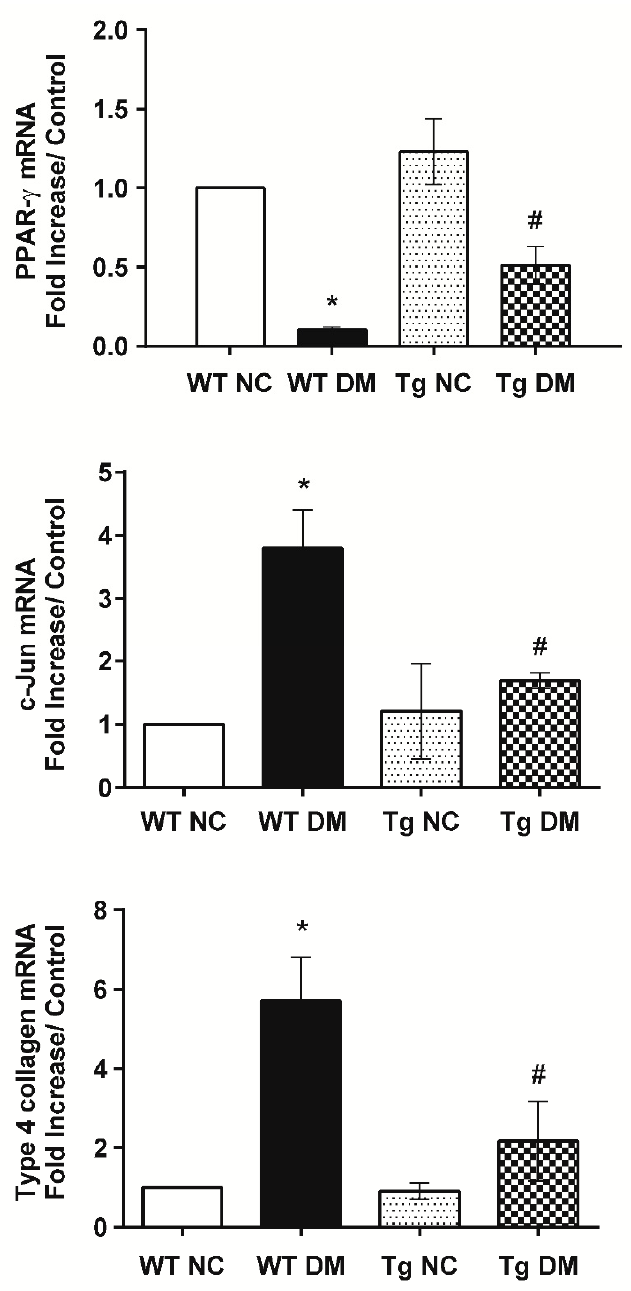
Figure 2. Reduction of c-Jun and type 4 collagen, but restoration of peroxisome proliferator-activated receptor- γ (PPAR- γ ) mRNA levels in miR-29a transgenic mice after induction of diabetes. The mRNA expression levels of c-Jun, type 4 collagen, and PPAR- γ , normalized to that of β -actin, in microdissected glomeruli of study animals were quantified by qRT-PCR (n = 6). The symbol * indicates significant difference vs. the WT NC group ( p < 0.05); the symbol # indicates significant difference vs. the WT DM group ( p < 0.05).